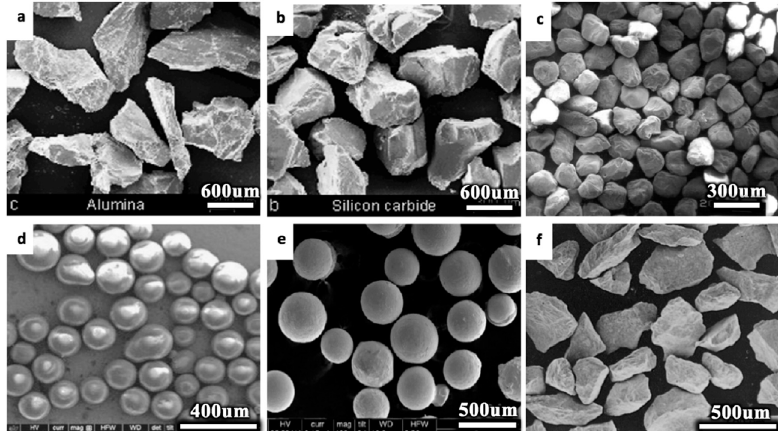
Figure 16. Particle materials and shapes used in experimental studies: ( a ) alumina [88], ( b ) silicon carbide [88], ( c ) quartz [89], ( d ) glass beads [90], ( e ) steel round grit [91], and ( f ) tungsten carbide [92].